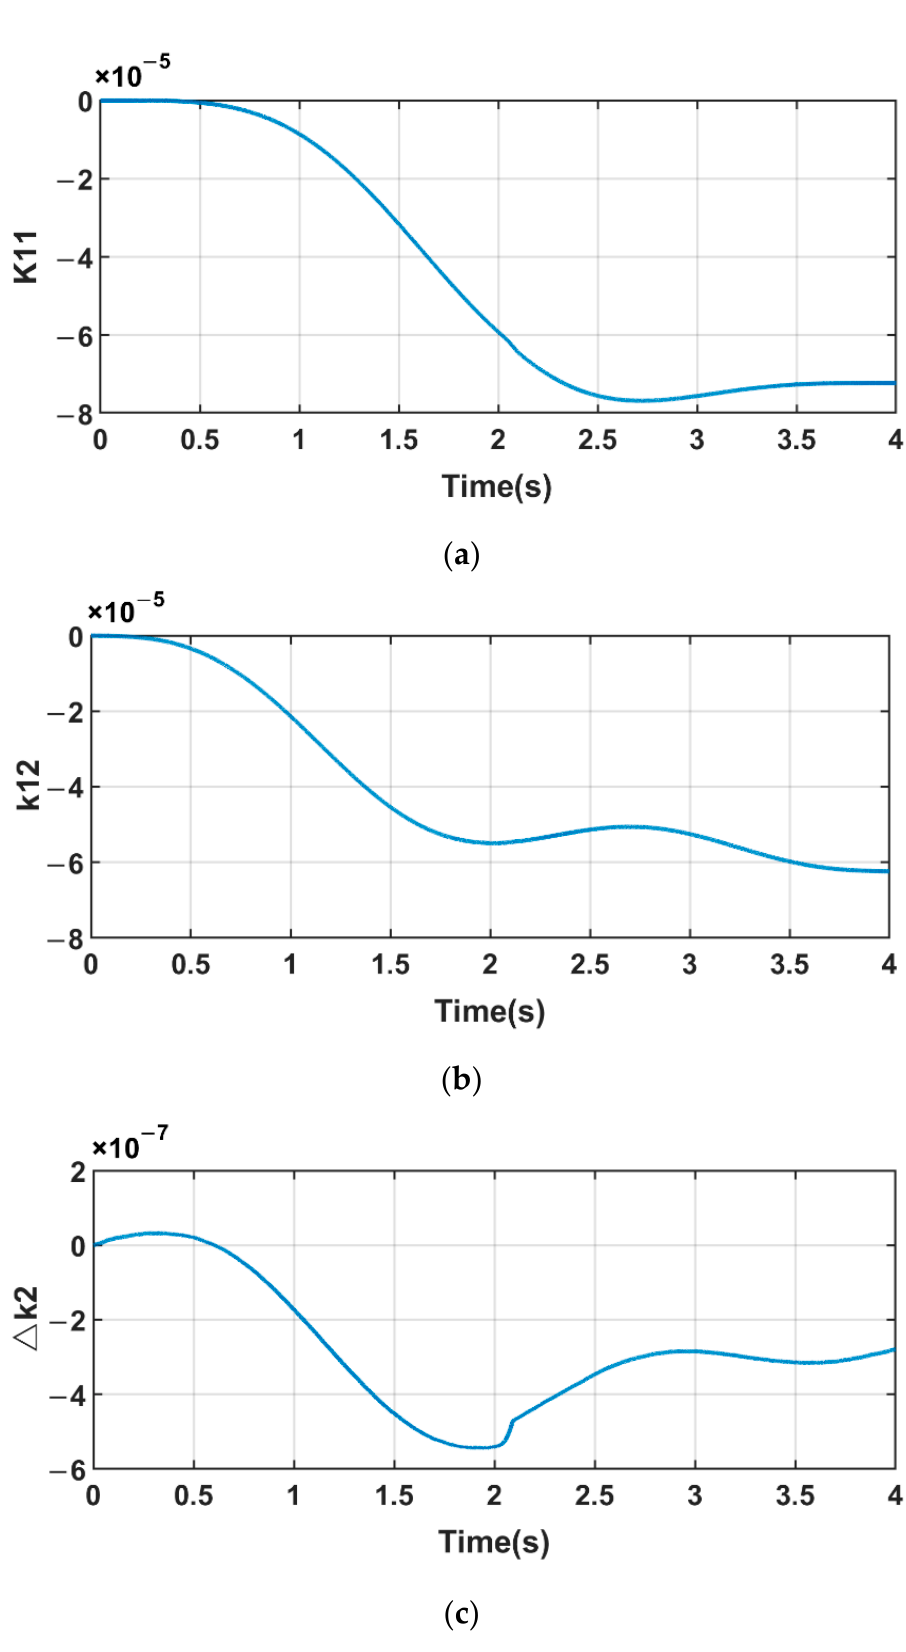
Figure 11. Comparison of the following error of two methods.